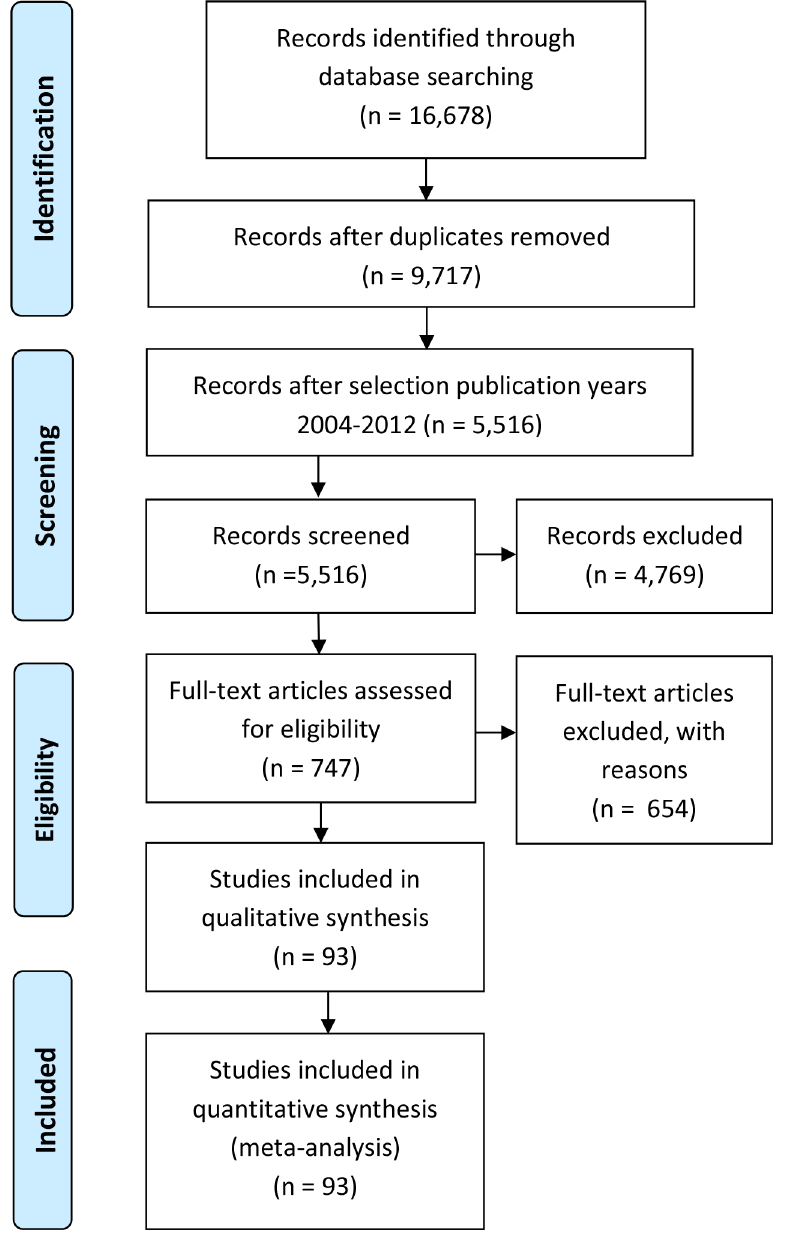
Fig 2. PRISMA flow